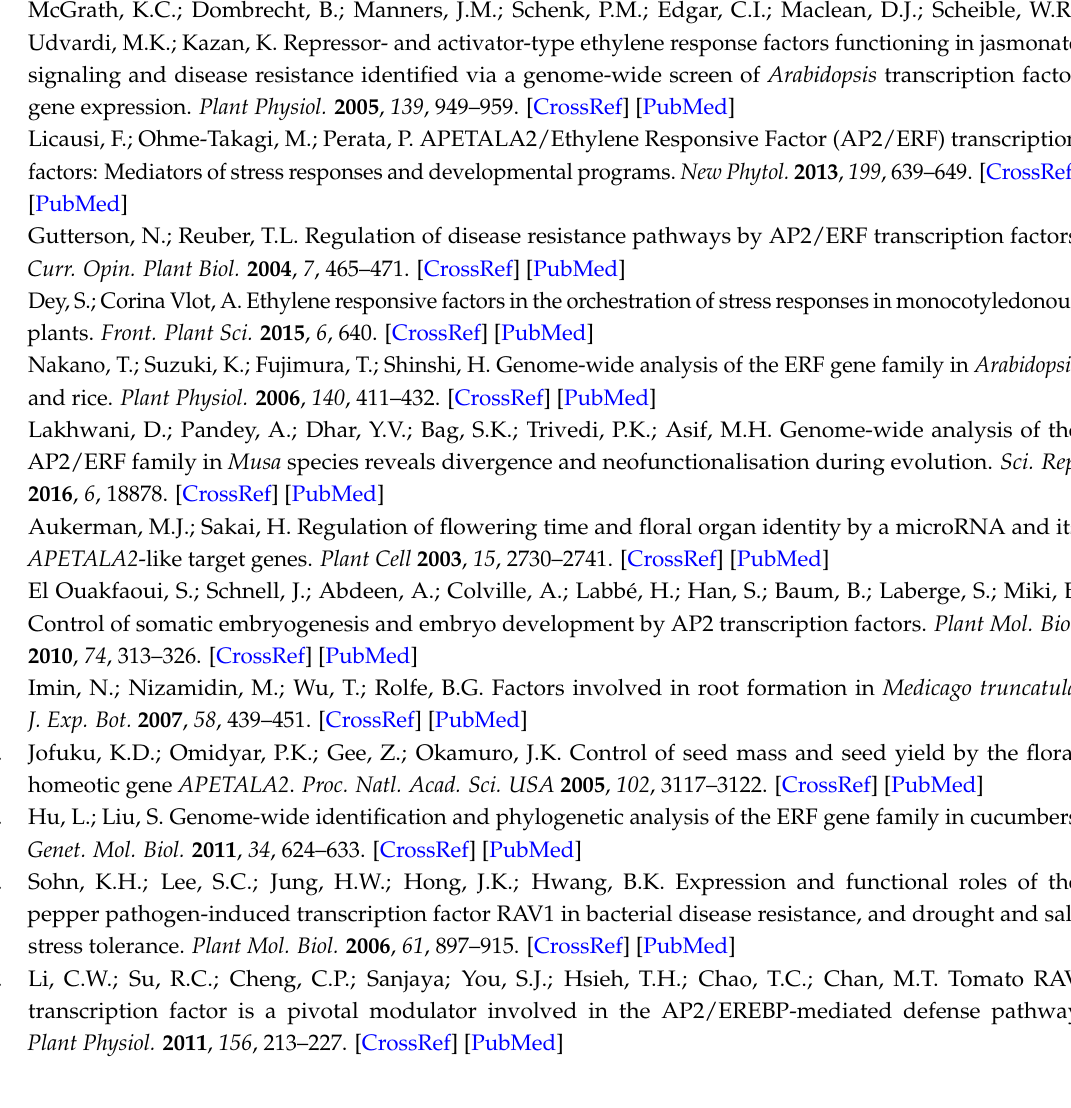
groups (COG) classification, Figure S8: Expression profiles of AP2 genes in response to F. oxysporum in the root of V. fordii and V. montana , Table S1: The individual APETALA2/ethylene-responsive element binding factor (AP2/ERF) genes identified in Vernicia fordii and Vernicia montana transcriptome database, Table S2: Conserved motifs identified from the ERF family in V. fordii and V. montana , Table S3: The one to one orthologous gene pairs and their corresponding Ka/Ks ratios, Table S4: List of specific primer sequences used for real-time PCR analysis, Table S5: Pearson correlation r between transcriptome data and qRT-PCR result of selected orthologous genes in V. fordii and V.